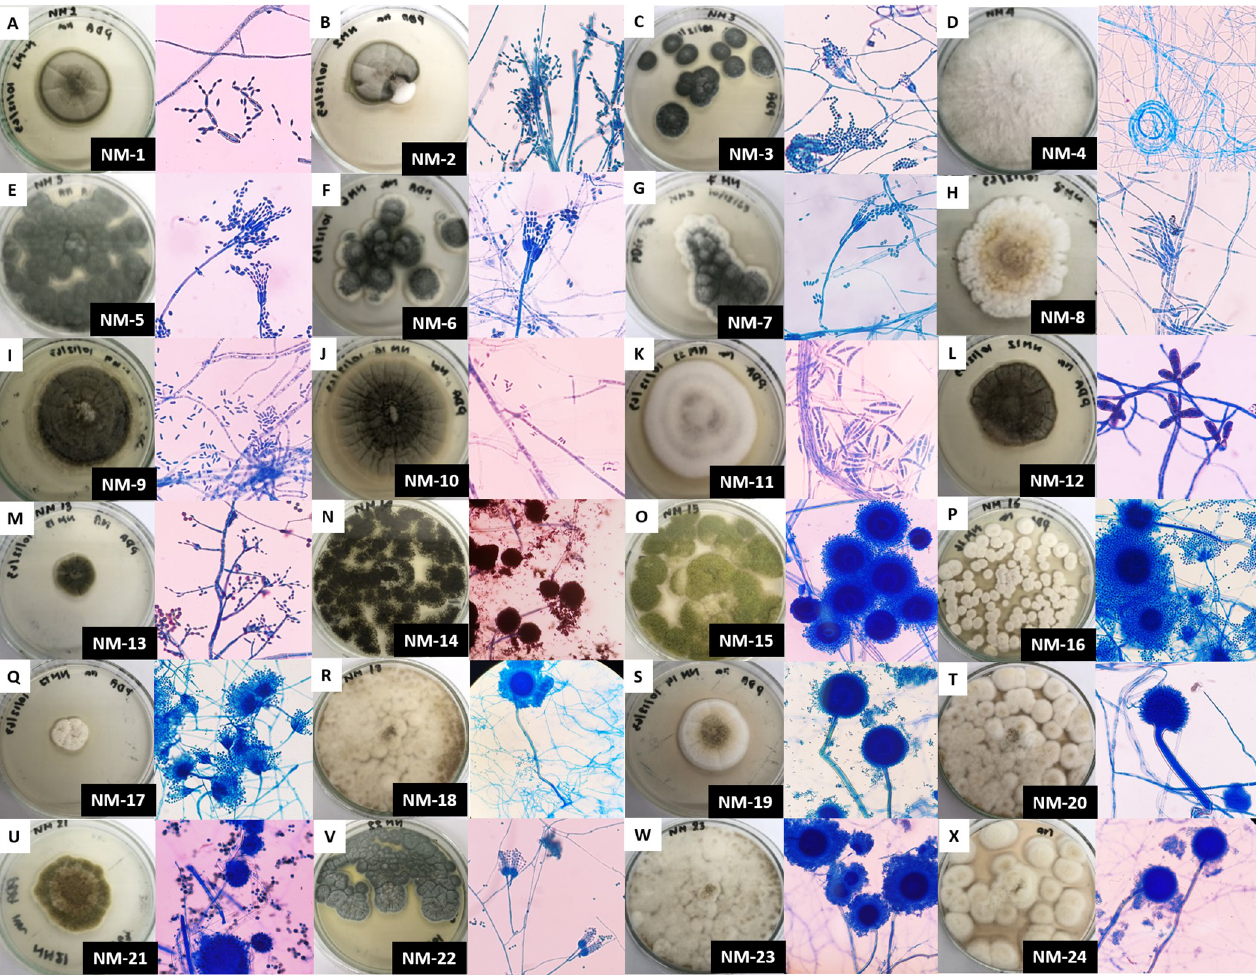
Fig 2. Morphological characteristics of the isolated fungi. Morphological observation of the 24 fungal isolates based on macroscopic and microscopic morphology (magnification x40). Colony morphology (left panel), microscopic morphology (right panel). All isolates were grown on PDA plates for 7–14 days at